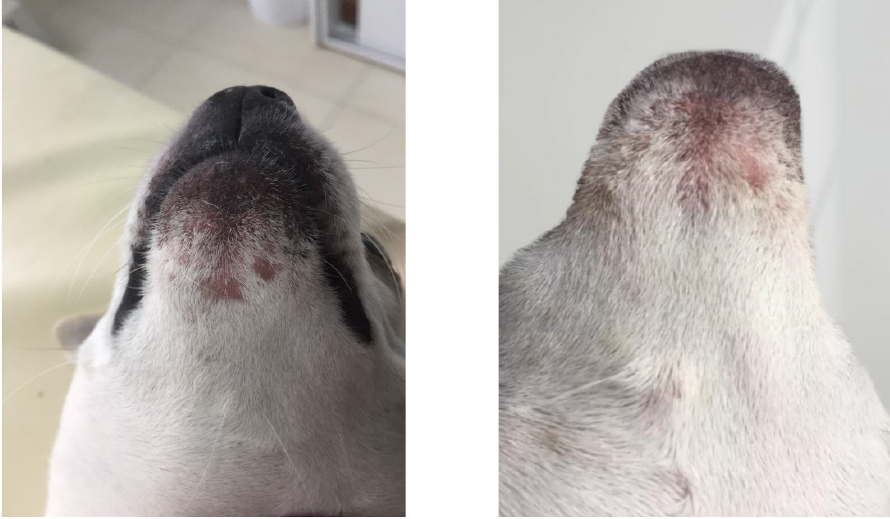
Figure 4. Treatment results of patient 4 with SILVER STOP ® cream. Any irritations caused by the cream were not reported in treated patients.